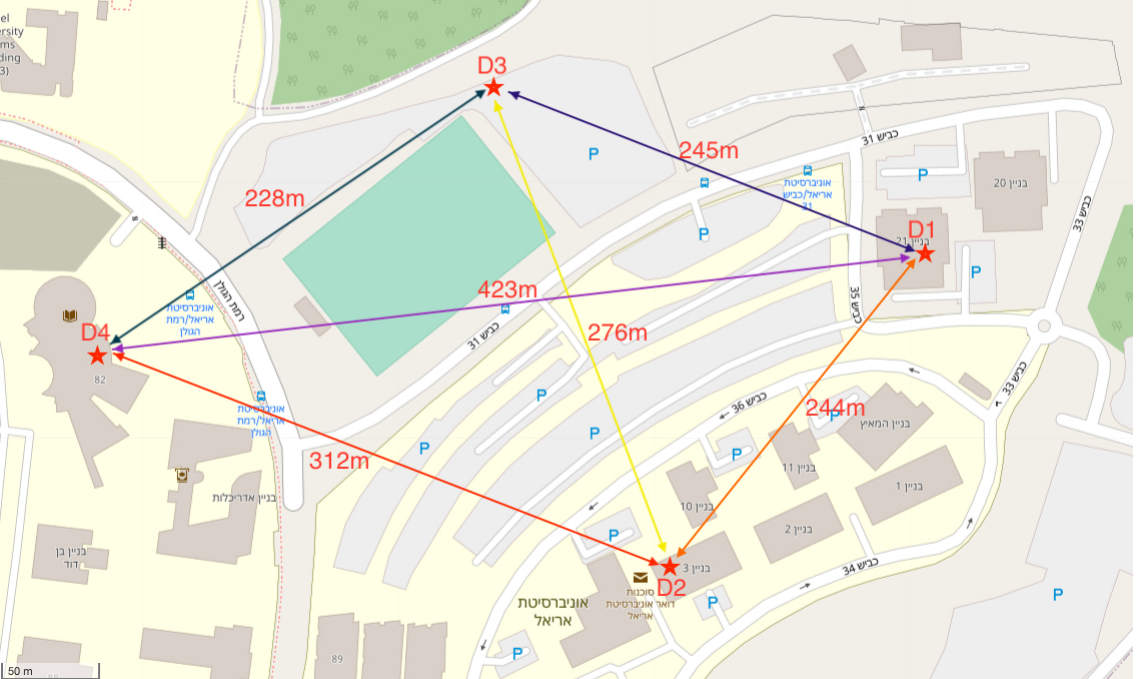
Figure 8. The layout of the nodes in the university area, as well as the distances between the nodes after the network started